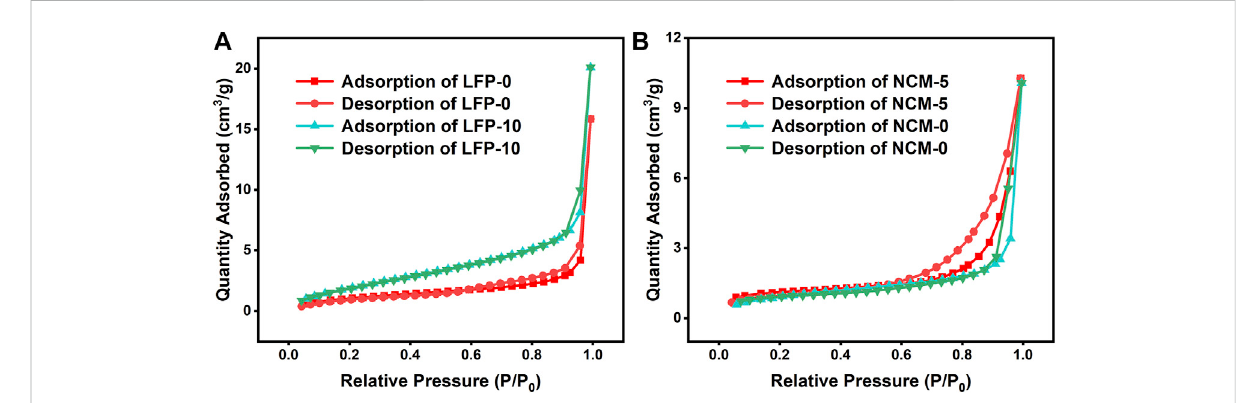
The N 2 adsorption/desorption curves of some cathodes: (A) LFP-0 and LFP-10; (B) NCM-0 and